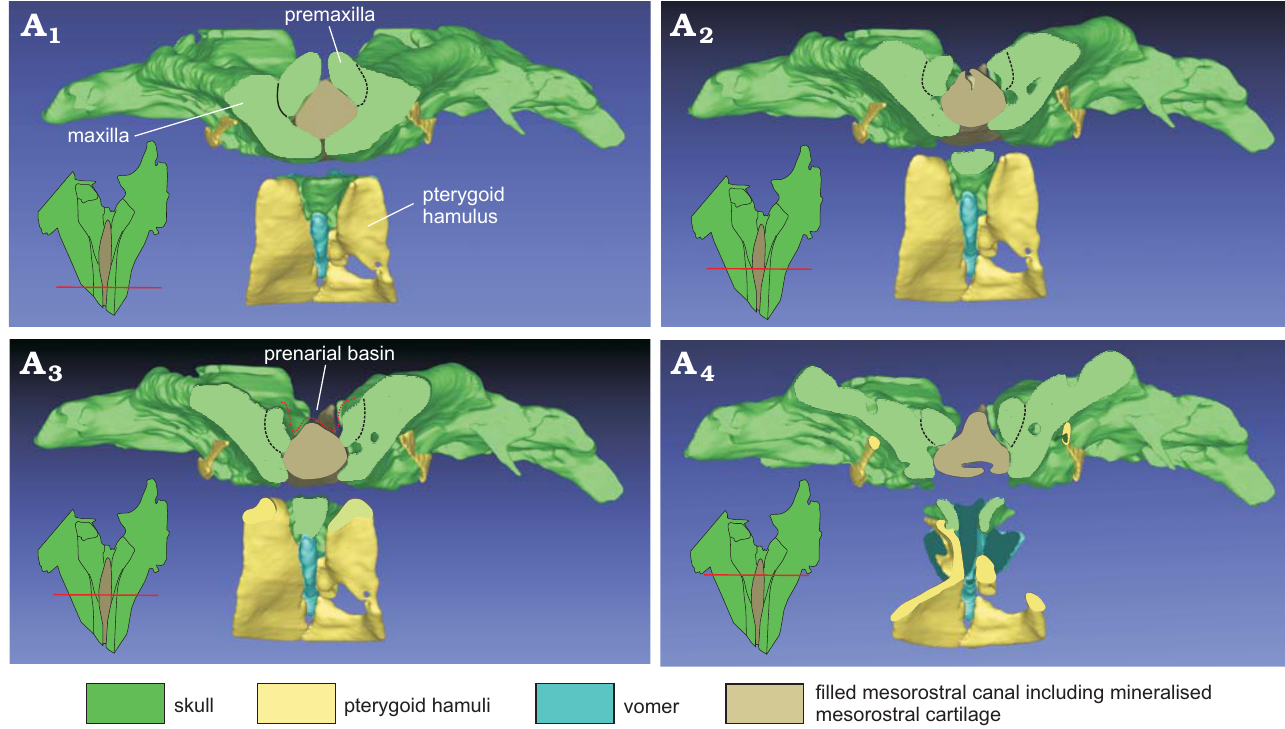
Fig. 4. 3D reconstruction resulting from the CT-scan of the ziphiid cetacean Messapicetus cf. longirostris Bianucci, Landini, and Varola, 1992 skull (MDM-2029) inside two limestone slabs from the Tortonian of Menorca (Balearic Islands, Spain); in anterior view, showing transverse cross sections of the rostrum (A 1 –A 4 ) made at different distances from the rostrum base. Not to